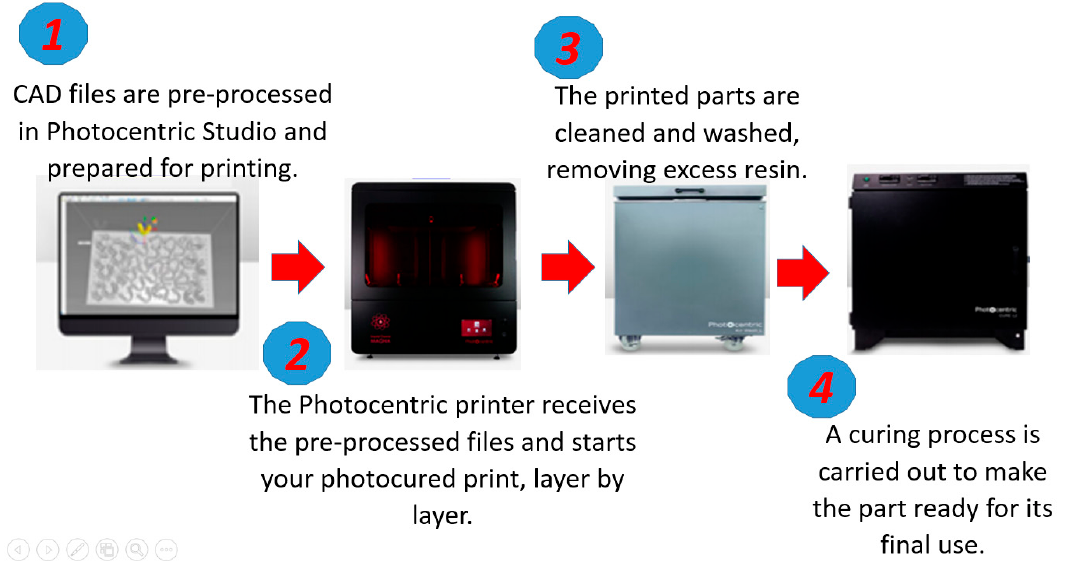
Figure 2. Printing workflow of the LC Magna stereolithographic 3D printer. Table 1. 3D printing parameters for the insert mold manufactured by